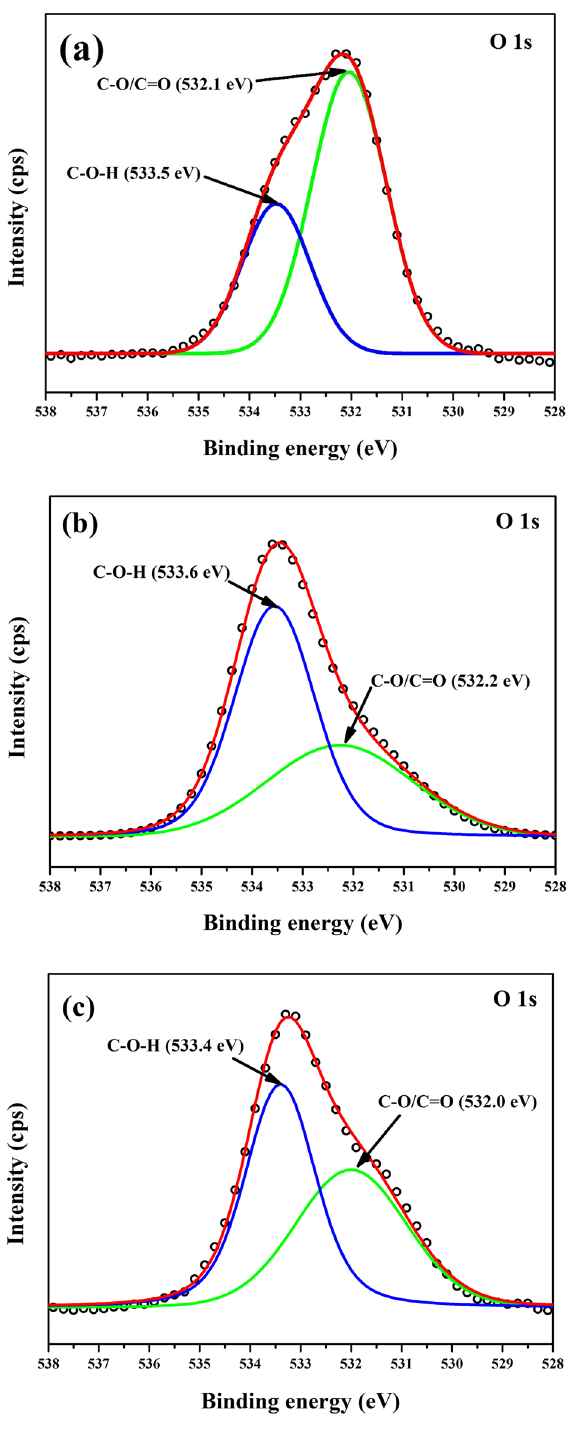
Figure 6. XPS spectra of O 1 s for ( a ) LA, ( b ) LAPC-1 and ( c )